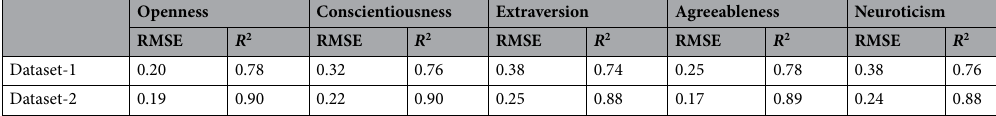
Table 2. Prediction results using position data for five personality traits using bayesian regression on both the